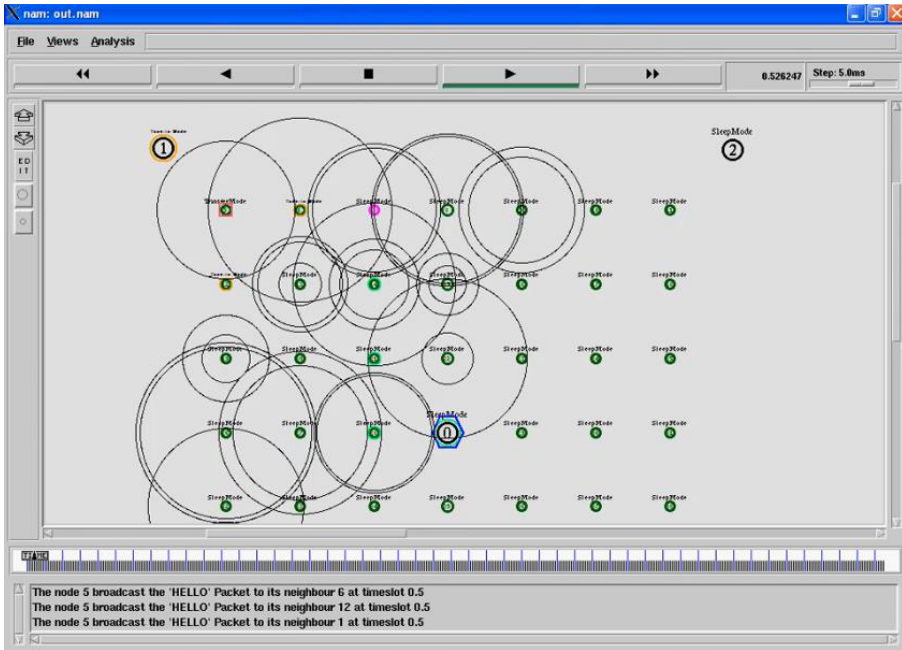
Figure 5. The activity modes of neighbour nodes of Node 5 by transmitting packets in a time